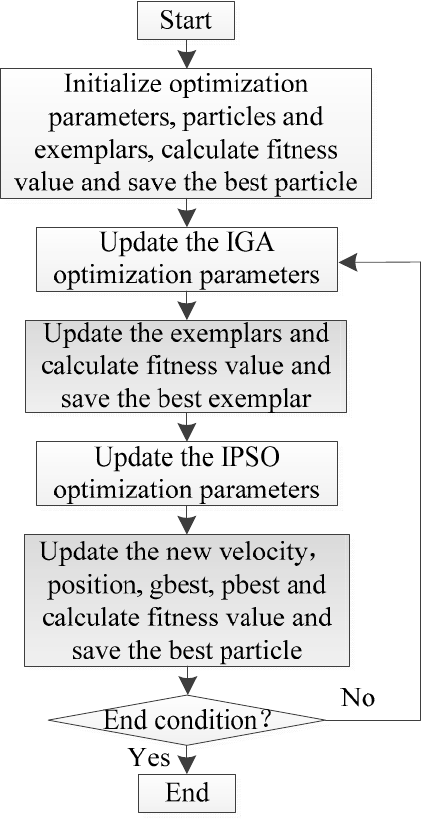
Figure 4. Flowchart of improved GLPSO algorithm.